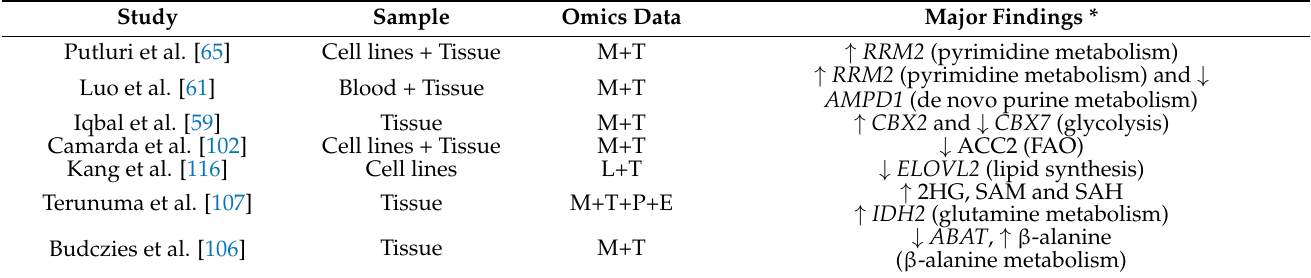
Table 3. Multi-omics studies focused on identifying metabolic alterations associated with BC prognosis.